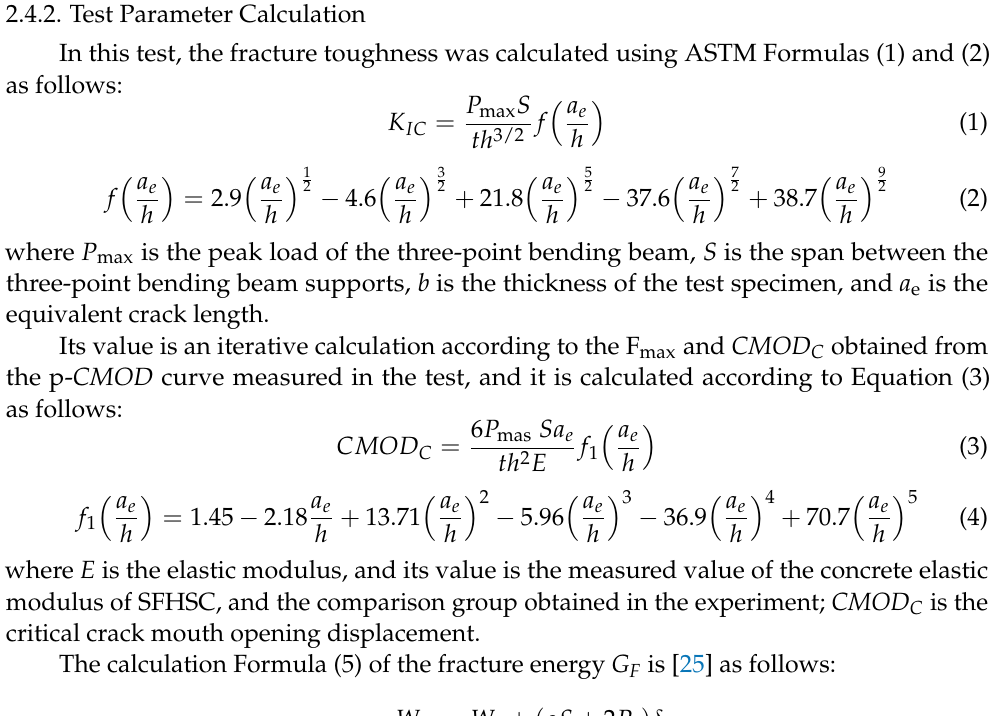
Figure 5. The schematic diagram of the TPBTs loading device.